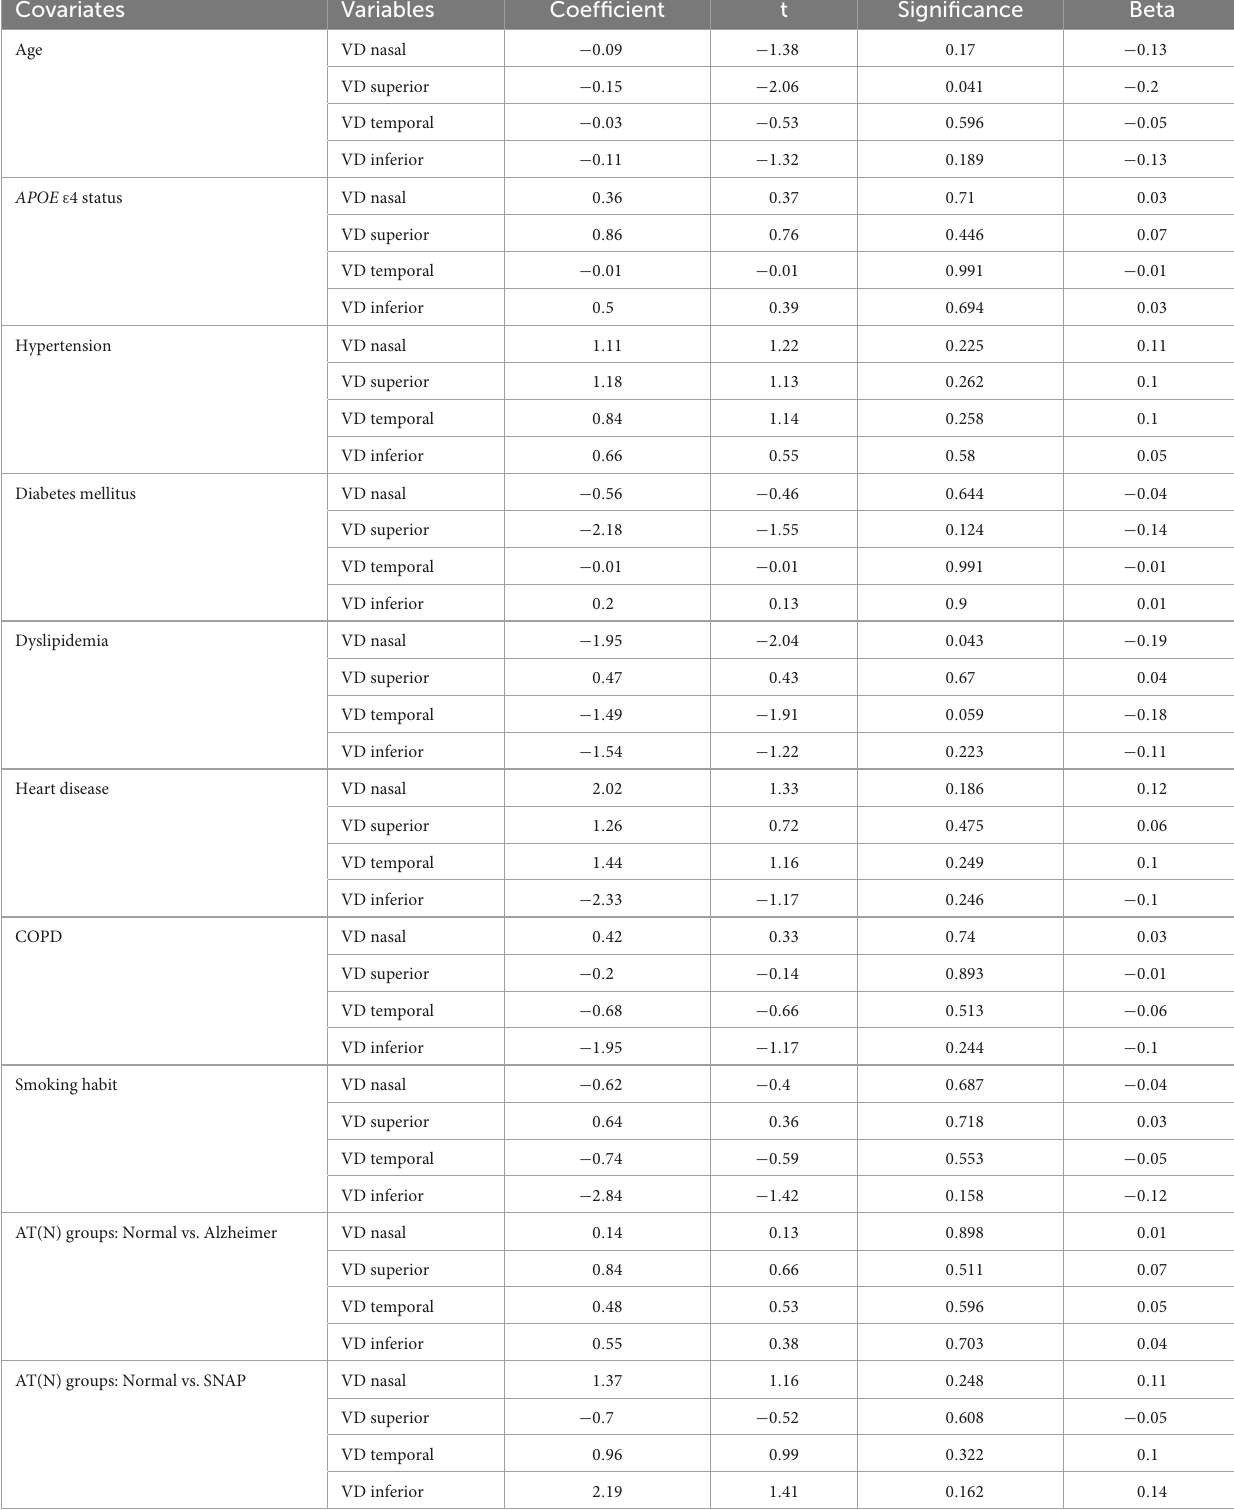
TABLE 2 Multivariate regression analysis of macular VD measurements. Covariates Variables Coefficient t Significance Beta